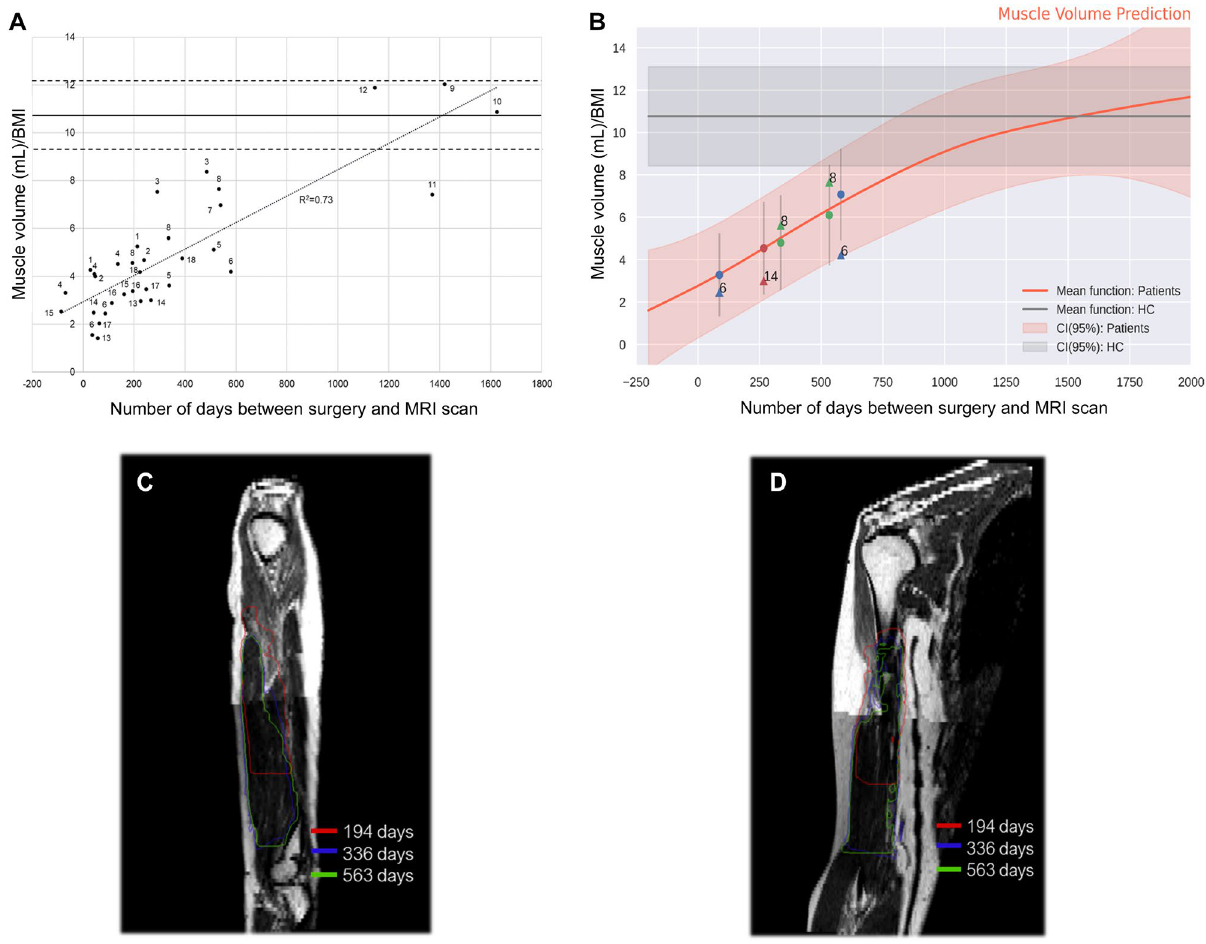
Figure 1. Changes in elbow flexor muscle volume pre- and post-nerve transfer. The numbers attached to the data points in ( A, B) are in reference to the case numbers provided in Additional file 1. ( A) Quantification of elbow flexor muscle volume at pre- and post-nerve transfer time points. The solid black line represents the mean uninjured elbow flexor muscle volume (n = 6) and the dashed black lines represent ± one standard deviation from the mean. ( B) Application of a Hierarchical Gaussian Process model to the data presented in ( A) . The solid black line represents the mean muscle volume/BMI of uninjured elbow flexor muscles (n = 6) and the shaded area represents one standard deviation from the mean. The circular data points represent the predicted values on the triangular points denote the actual data points. ( C–E) Represents deformable registration of elbow flexor muscle segmentations from case number 8 (Additional file 1) 194, 336 and 553 days post-nerve transfer. ( C) Sagittal plane. (D) Frontal plane. Supplementary Video 1 shows the 3D reconstruction video of reinnervated elbow flexor muscles of C and D Fig. 4). Visual representations of reinnervated elbow flexor muscle volume measurements from case number 8 (Additional file 1) post-operatively are shown in Fig. 1C–E. Objective assessments of muscular function. MRC grading. Volumetric measurements directly cor- related with function. An MRC grade of 0, 1, 2, 3 and 4 was associated with a mean reinnervated muscle volume per unit BMI of 2.28 (±0.7), 3.20 (±0.56), 3.96 (±0.81), 4.57 (±1.36) and 8.37 (±2.49) respectively (Fig. 2A). Uninjured muscles (MRC grade 5) had a mean muscle volume per unit BMI of 10.76 ( ±1.42) (Fig. 2A). There was a statistically significant difference ( p <0.001) in muscle volume per unit BMI between MRC grade four and zero, five and zero, four and one, five and one, four and two, five and two, four and three as well as five and three (Fig. 2A). Using the muscle volume per unit BMI and temporal measurements from Fig. 1B, the HGP model was used to infer objective (MRC grading) (Fig. 2B). The HGP model was able to predict MRC grade with an MAE of 0.73 and a mean Log likelihood of 0.28 (Supplementary Material Fig. 4). This means that the HGP model was able to predict within ±1 MRC grade. PVF measurements. The population mean force generated by reinnervated elbow muscles was 12.55KgF ( ±6.75) compared to 31.51KgF ( ±5.67) for uninjured arms. This was a statistically significant differential